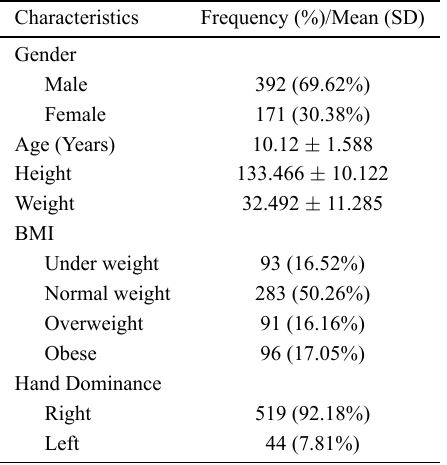
Table 1. Personal characteristics of